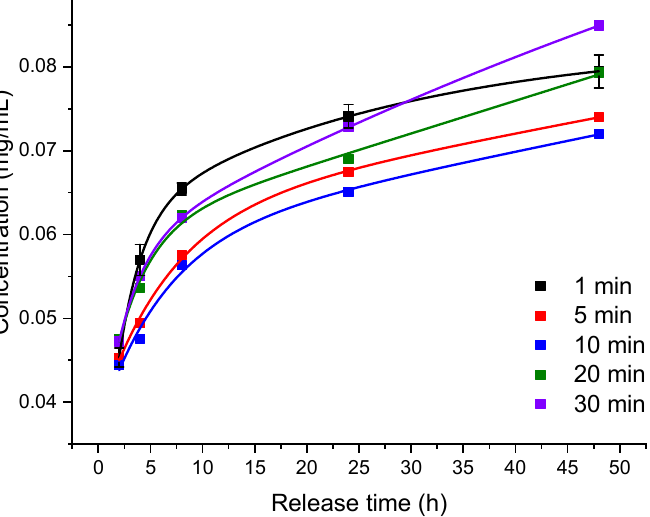
Figure 4. Influence of exposure time on the in vitro CPZ release profile from GelMa hydrogels resulting from 266 nm laser exposure up to 30 min at 0.75 mJ beam energy, as measured in PBS solution at 37 °C.